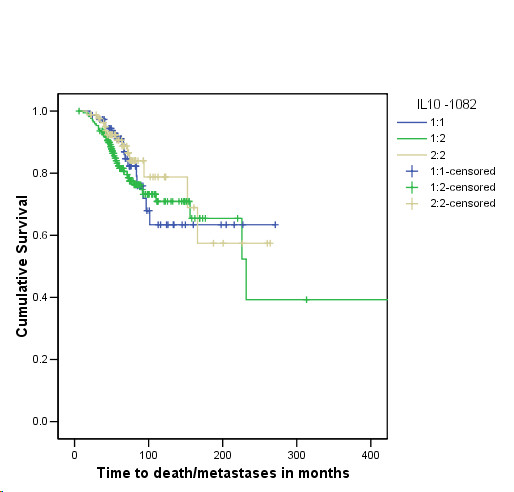
shows the time to death or metastases in invasive breast cancer for the genotypes of the IL10 -1082 polymorphism. Log Rank test statistic = 1.34; df = 2; p = 0.51 (n = 332).